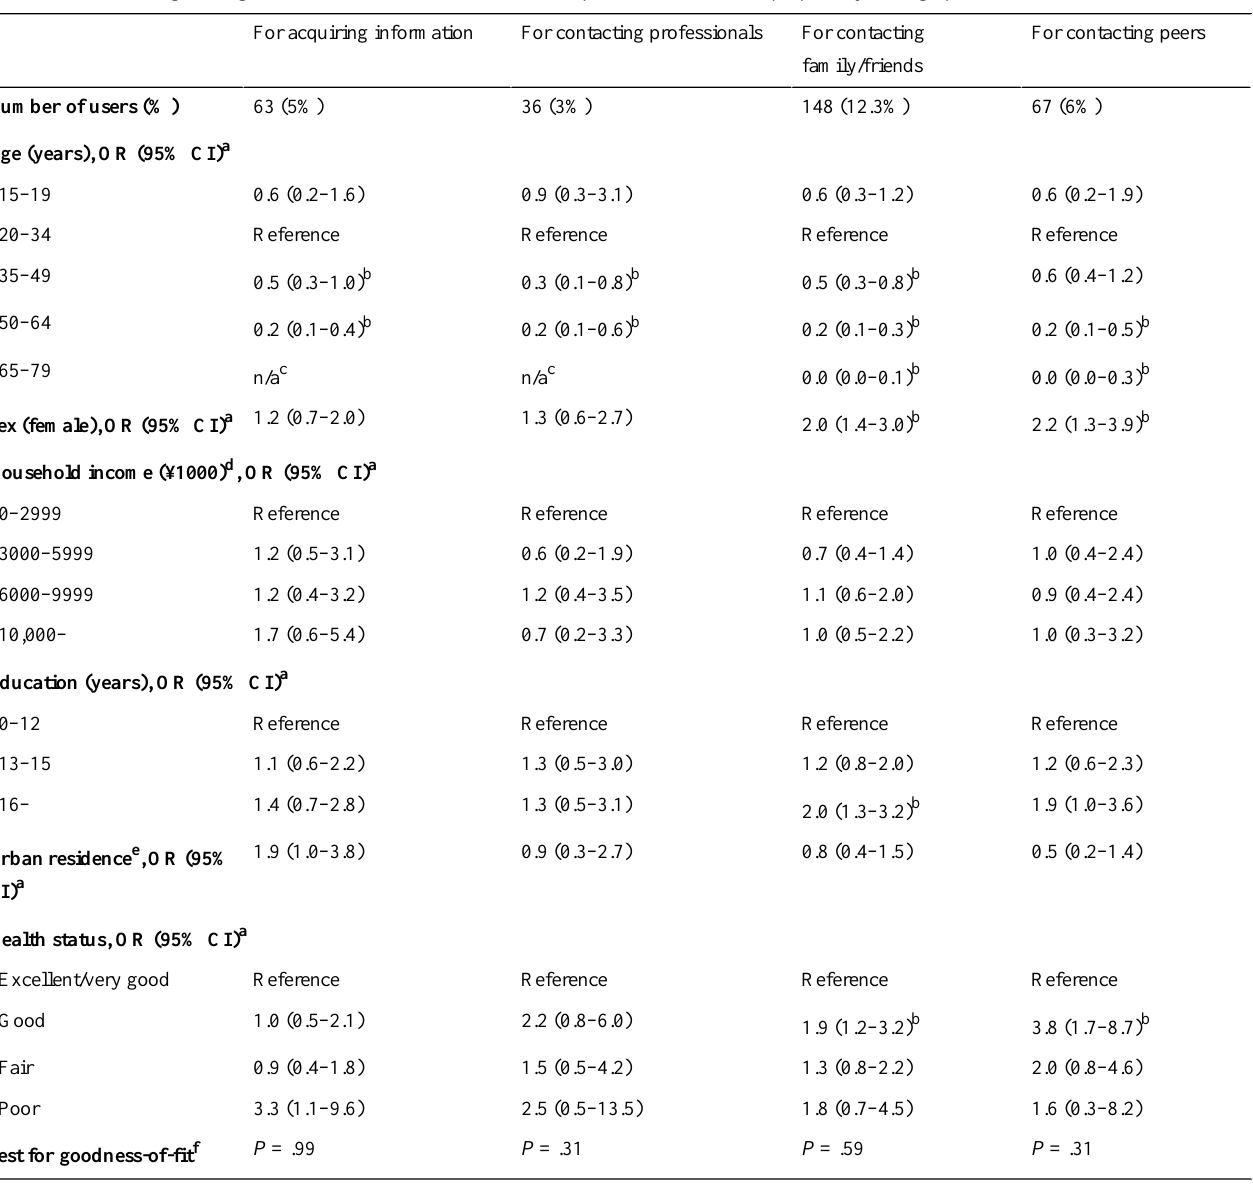
Table 4. Results of logistic regression models for Internet use via cell phone for each health purpose by demographic characteristics (N = 1200)